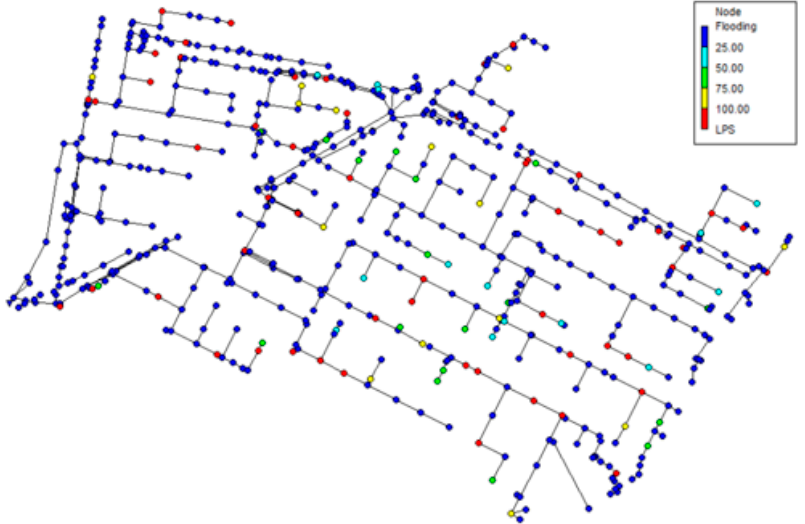
Figure 8. Results for the initial assessment of the Southern Chicó Network.